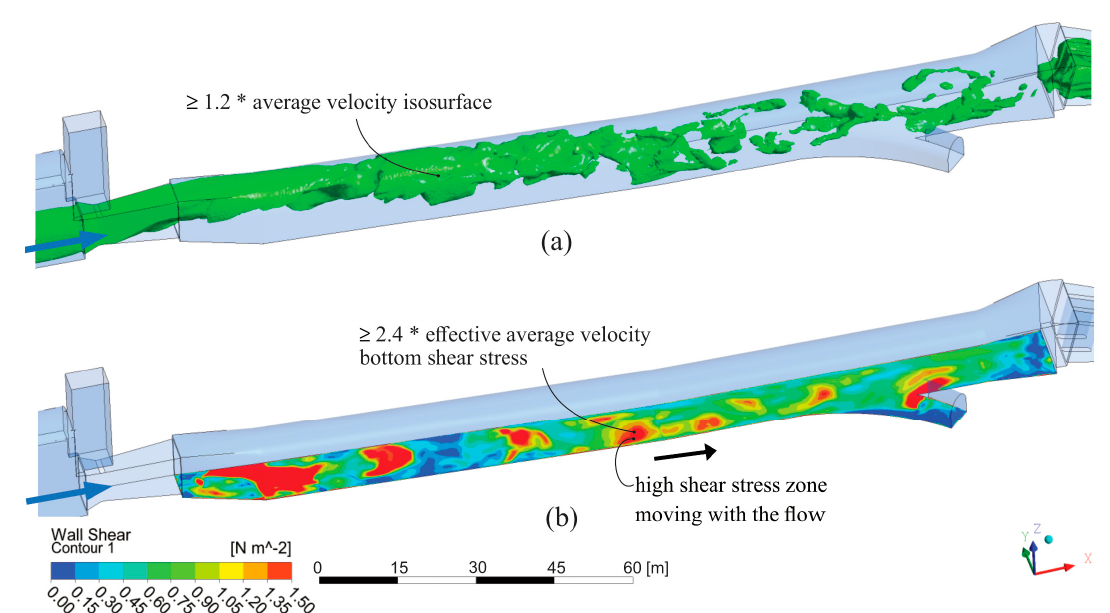
Figure 8. Geometry scale 1:1, 80 m³/s discharge, time 372 s (flow through factor 1.56 [–]). ( a ) Isosurface for 0.81 m/s equivalent to 1.2 * average sand trap velocity, and ( b ) resulting bottom shear stress.